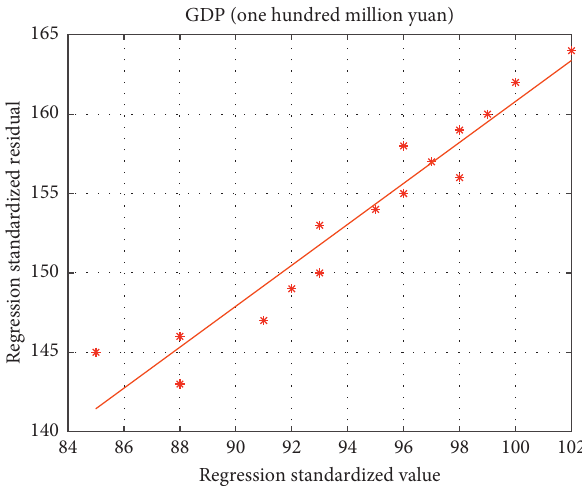
Figure 7: Grey correlation analysis residual scatter diagram.